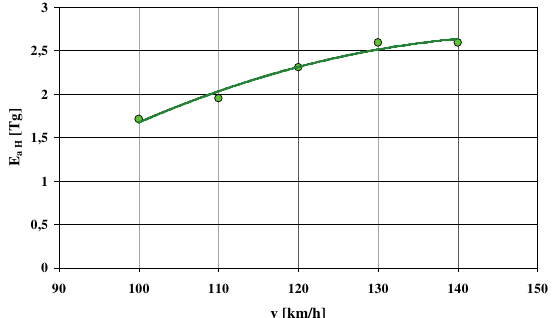
Fig. 21. Dependence of the national annual emission of carbon dioxide from passenger cars upon the average velocity, under model conditions